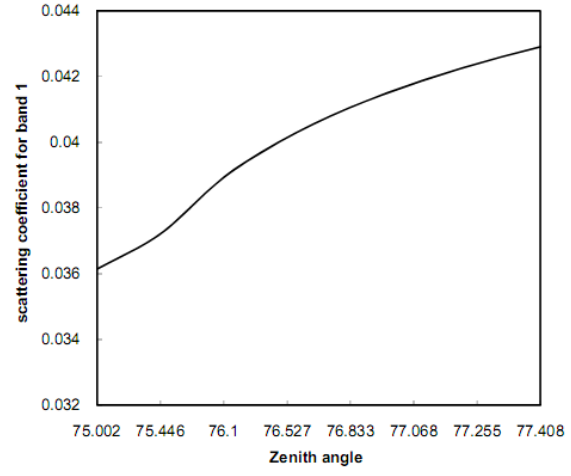
Figure 1. Scattering coefficient versus solar zenith angle for band 1 for the atmospheric